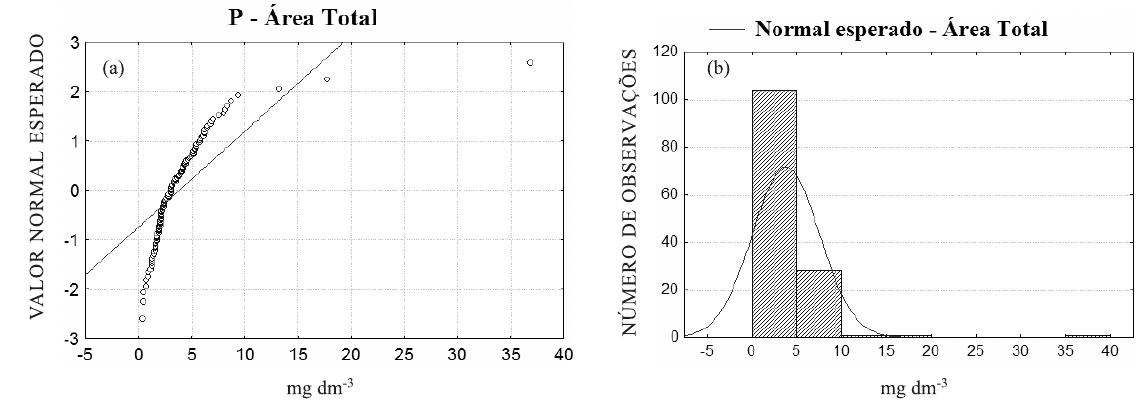
Figura 3. Gráfico de normalidade (a) e distribuição das classes de frequência (b) dos teores de P em área total.